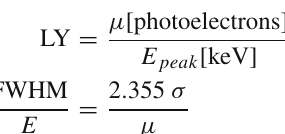
Fig. 4 Distribution of mean time vs. energy of α (red) and β / γ (black) events. The blue dotted line shows our typical separation cut